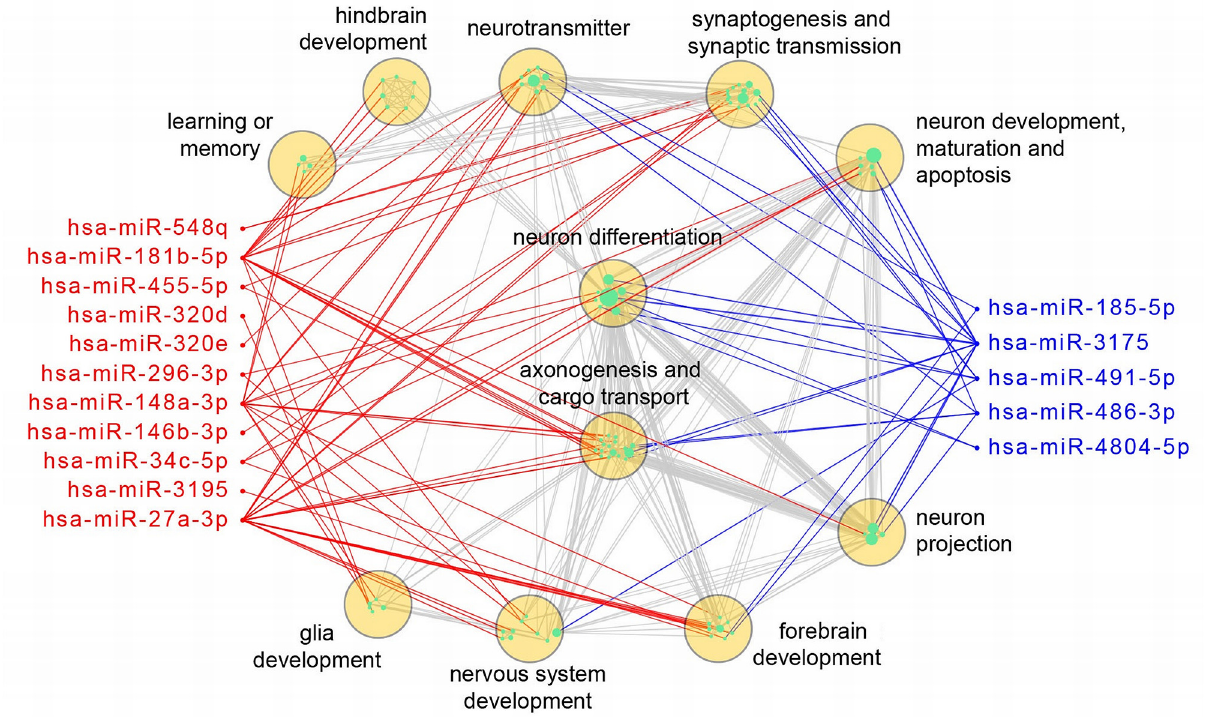
Fig 3. A network view of neurological function of significantly altered miRNAs. Red nodes stand for up-regulated miRNAs, blue for down-regulated miRNAs, and cyan for enriched GO terms (n = 91, with sizes proportional to the numbers of predicted miRNA targets). GO terms were further classified into broader function groups (yellow circles) by QuickGO. A red or blue edge indicates a GO term was enriched in the predicted targets of up-regulated or down- regulated miRNAs, respectively. Grey edges link GO terms with overlapped targets (overlap coefficient > 0.5). This network was created by the Cytoscape